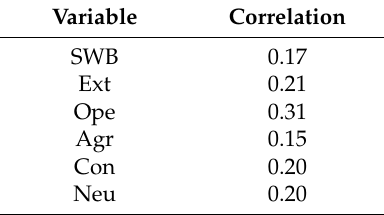
Table 3. Correlations between observed and machine learning-derived FFM traits and